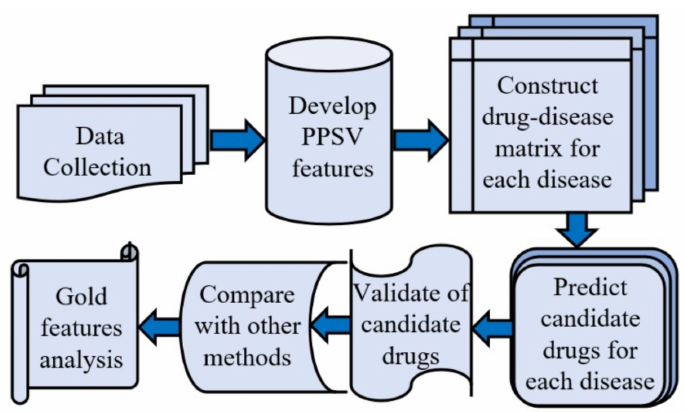
Figure 1. The workflow for identifying drugs for a